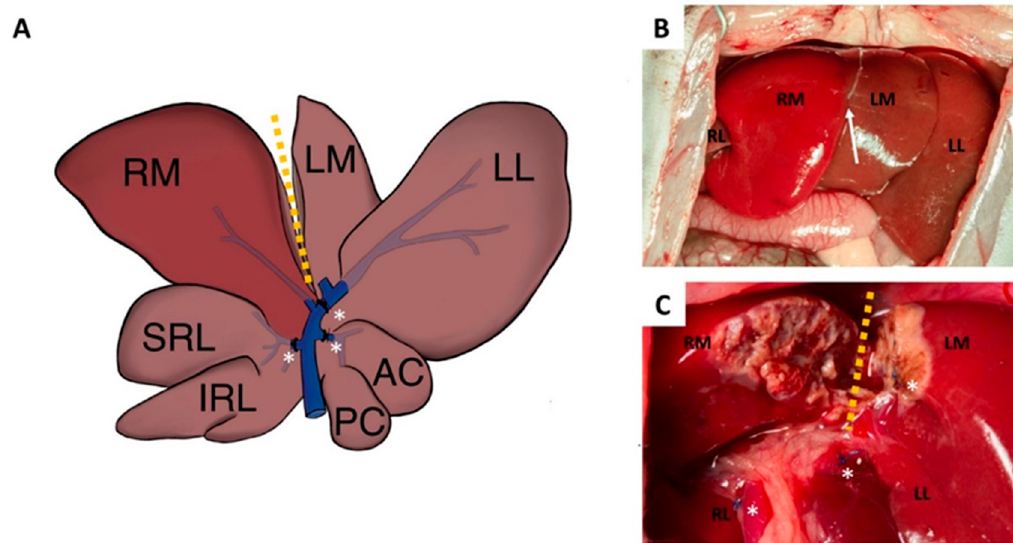
Figure 2. Schematic figure ( A ) and photographs ( B , C ) of the operative procedure on rats. Following median laparotomy, in the case of portal vein ligation (PVL), the portal branches leading to the right lateral (RL), left part of the median lobe (LM), left lateral lobe (LL), and the caudate lobe were ligated (*). The non ‐ ligated lobe comprised the right median (RM) lobe. In the case of ALPPS, additional transection (yellow dotted line) was performed alongside the transition line (white arrow) between the RM and LM lobes.